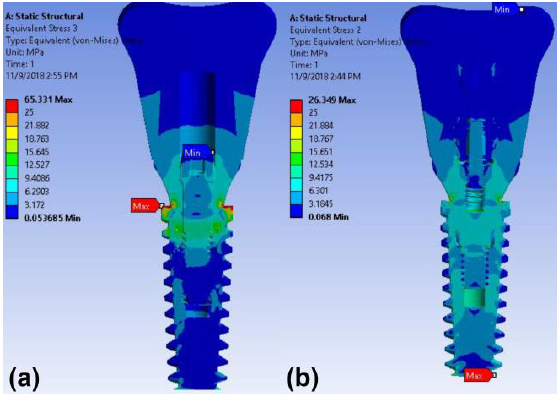
Figure 4. Color-coded von Mises stress distributions in the surrounding bone and implant under 100 N vertical load in the finite element model: ( a ) cement-retained and ( b ) cementless screw-retained zirconia crown models.